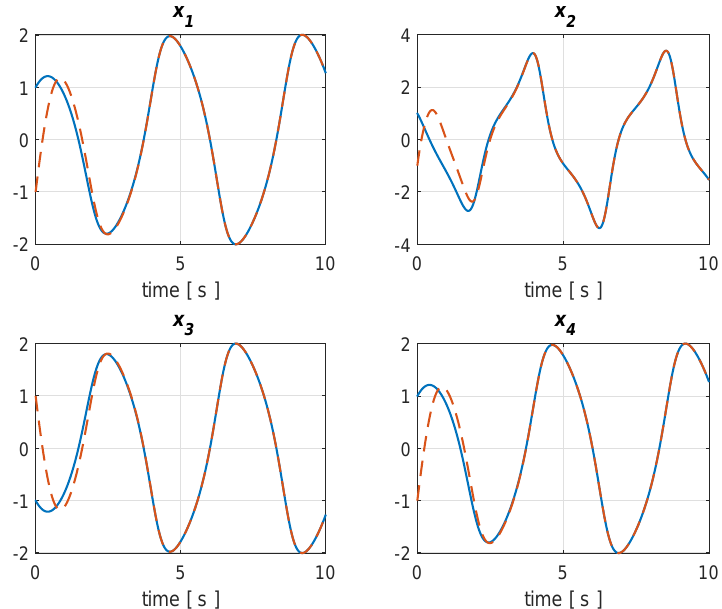
Figure 1. Simulation run without noises and with x ( 0 ) = ( 1,1, − 1, − 1 ) and ˆ x ( 0 ) = ( − 1, − 1,1,1 ) , where the state variables are in blue and their estimates are in dashed